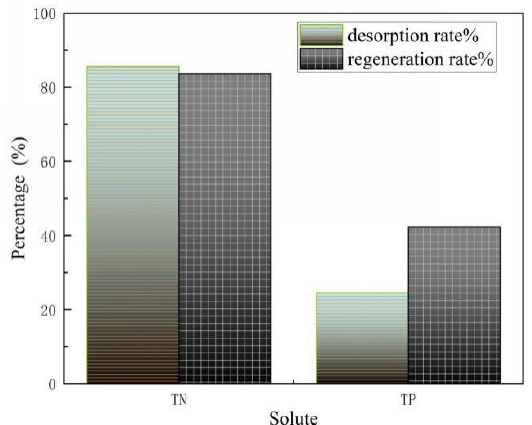
Figure 14. Desorption and regeneration of nitrogen and phosphorus by saturated SOD adsorption.